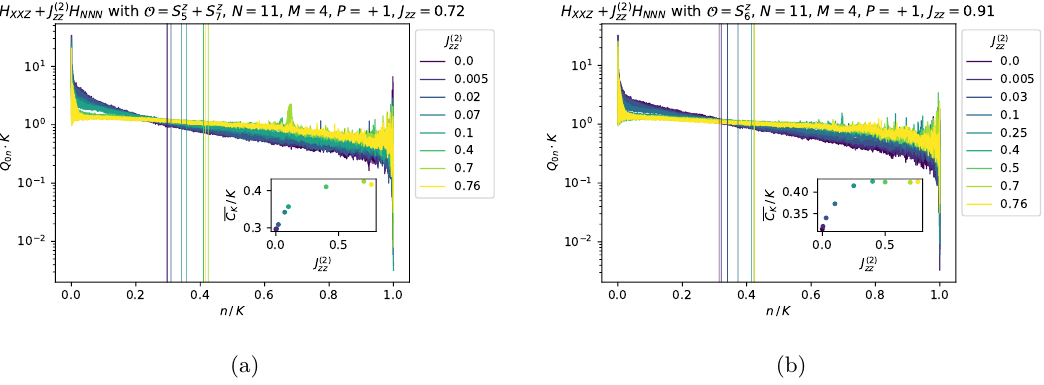
Figure 5. Results for the saturation value of K-complexity computed for a local operator of the form (3.5) with trace removed, for H N = 11 , M = 4 , P = +1 . Left: with J zz = 0 . 72 , for the operator O = S z J zz = 0 . 91 , for the operator O = S z Inset: dependence of KC saturation value on the strength of the integrability-breaking term.